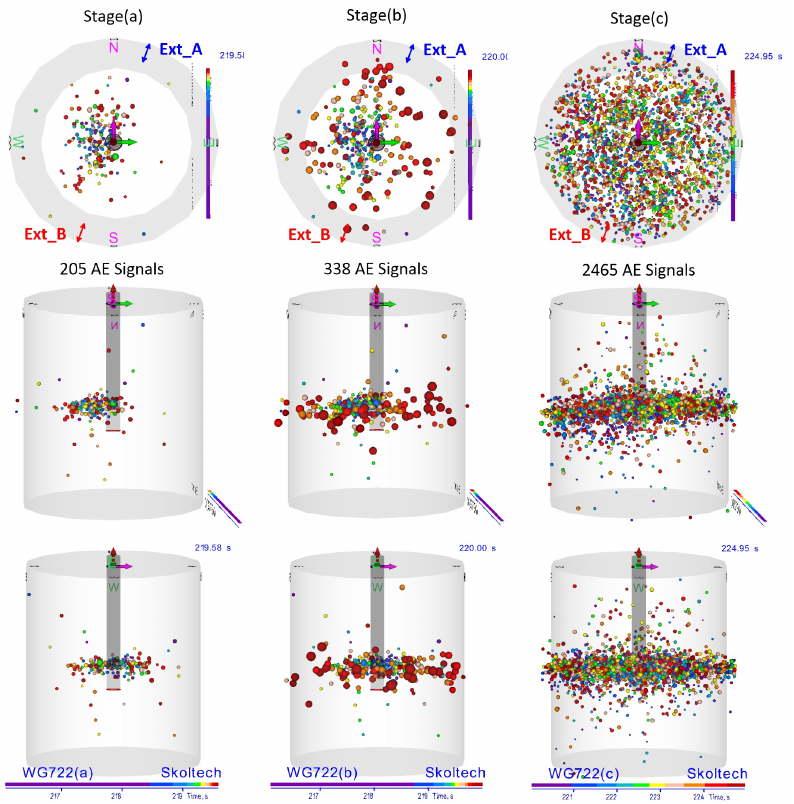
Figure 17. Three orthogonal projections of positions of AE signals in the space of the WG-722 sam- ple.